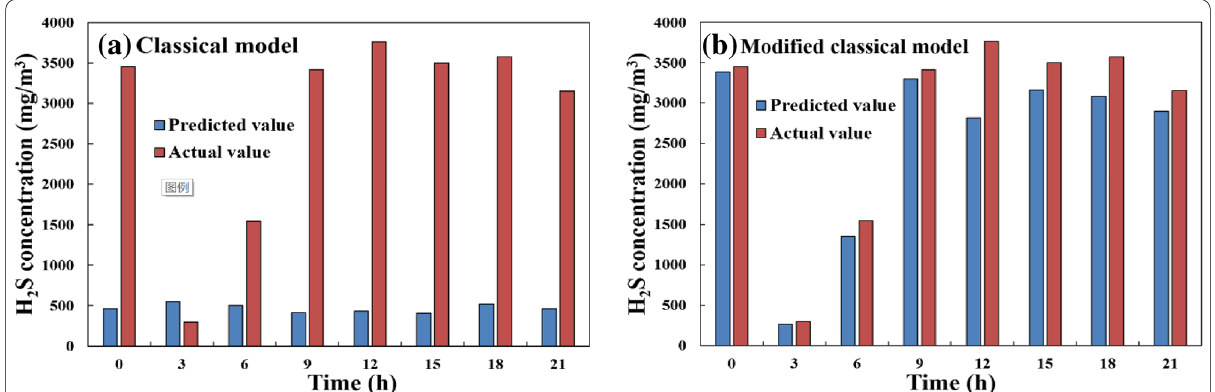
Fig. 6 Predicted and measured values of H 2 S in AD of pig manure with high total solids